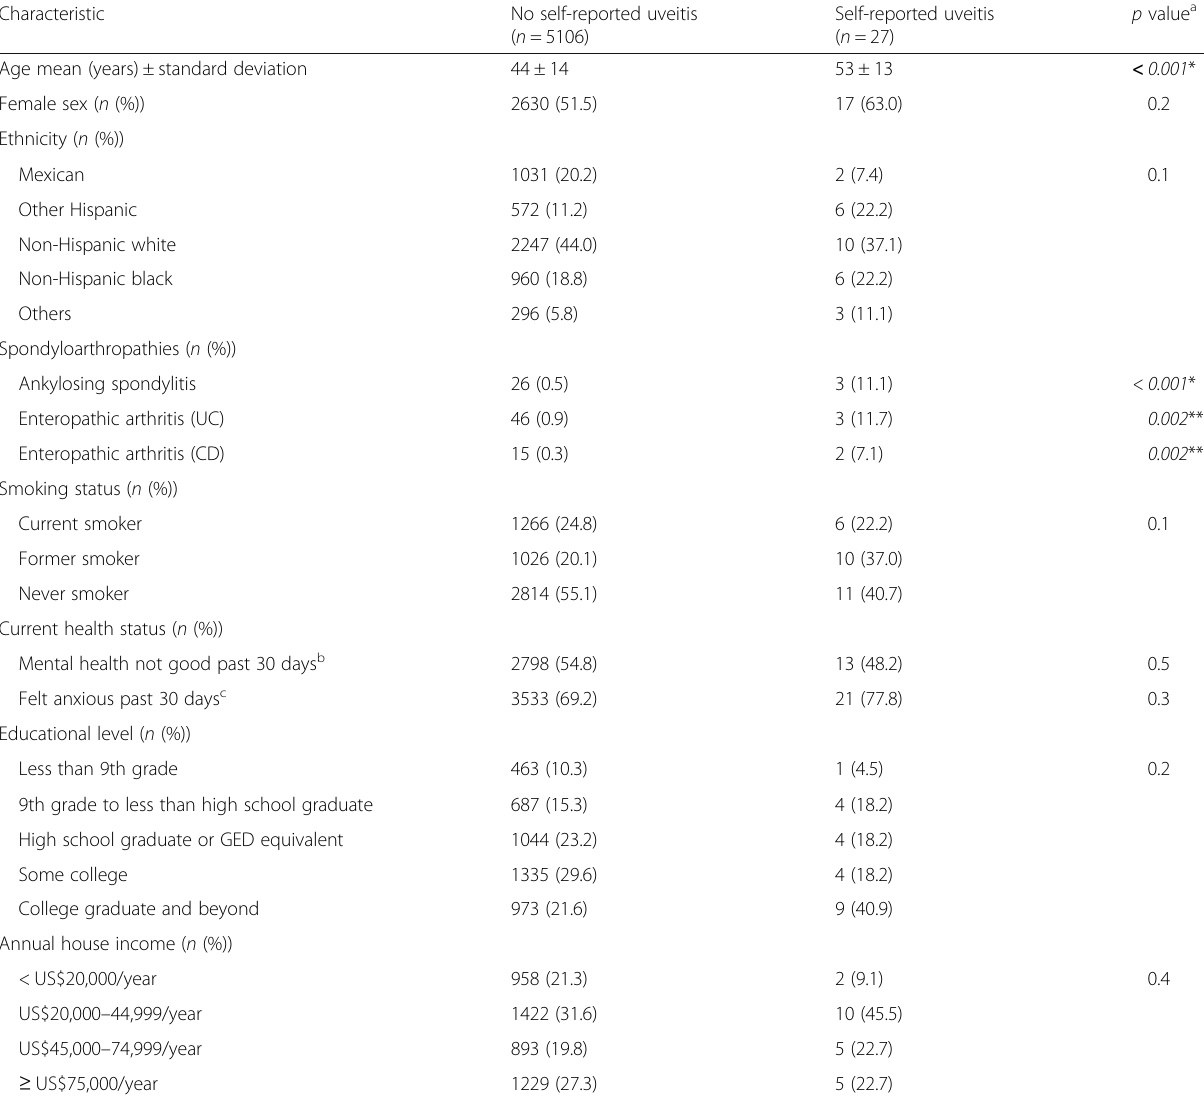
Table 1 Demographic and clinical characteristics of the population Characteristic No self-reported uveitis